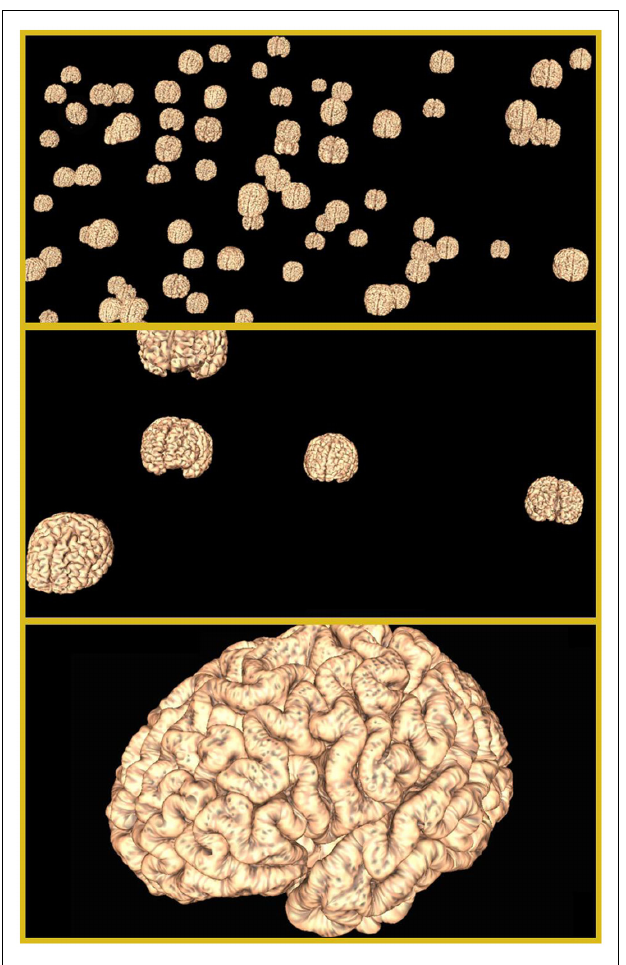
FIGURE 2 | Informatics visualization for neuroimaging navigable graphical environment. INVIZIAN supports the loading of hundreds of MRI surfaces into its interactive graphical environment (top).The user is able to pan, rotate, and zoom in on the data collection (middle). For each surface, as the user zooms closer, higher resolution versions of the surface are seamlessly swapped in (bottom) to allow the viewing of finer detail while maintain smooth interactivity.